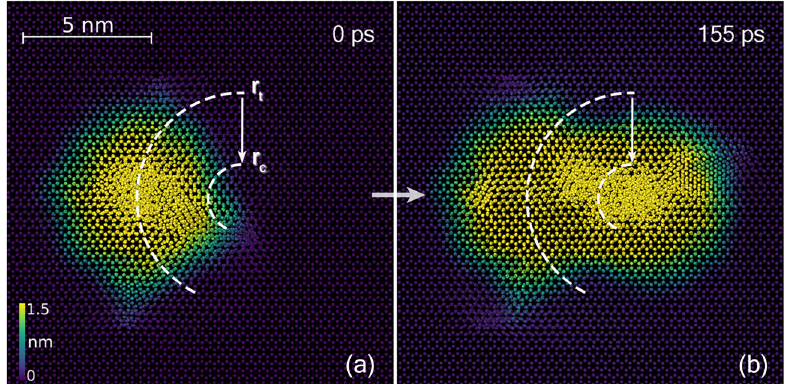
Fig. 5 Recrystallisation of the ion track when overlapped by a second ion for the case of the 185 MeV Au irradiation in the deeper regions. a Plan-view image of a track induced by a fi rst impact. b Final stage of the cell after an impact overlap event. The concentric circles mark the position of the second impact with the inner and outer circles representing the amorphous and recrystallised cross-sections of the track,